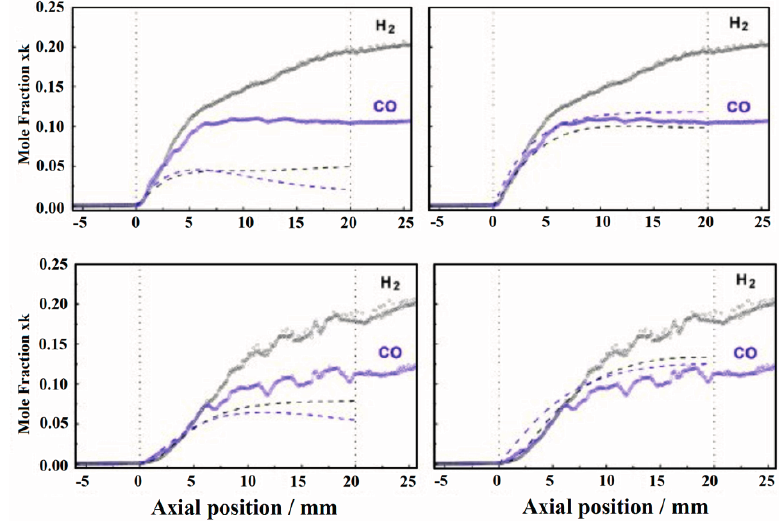
and CO vs axial position, with a gas feed of CH 2 /O /Ar = 1184/592/2224 mln/min respectively [11]. 4 2